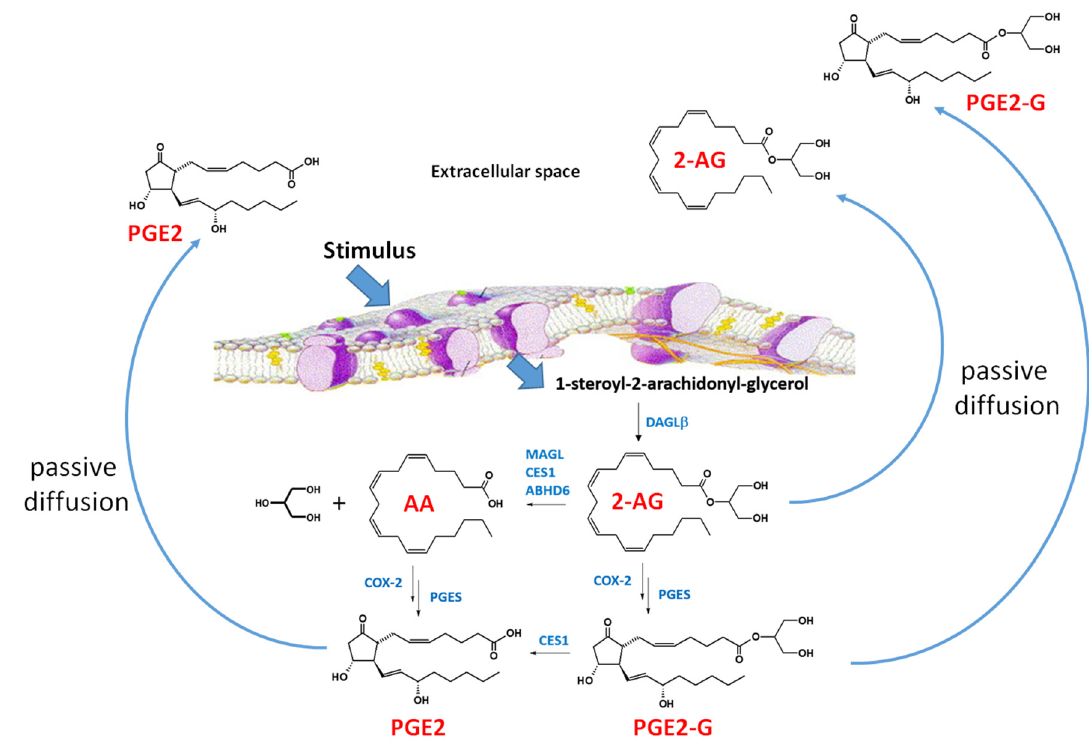
Figure 3. 2-Arachidonylglycerol biosynthesis and degradation in macrophages